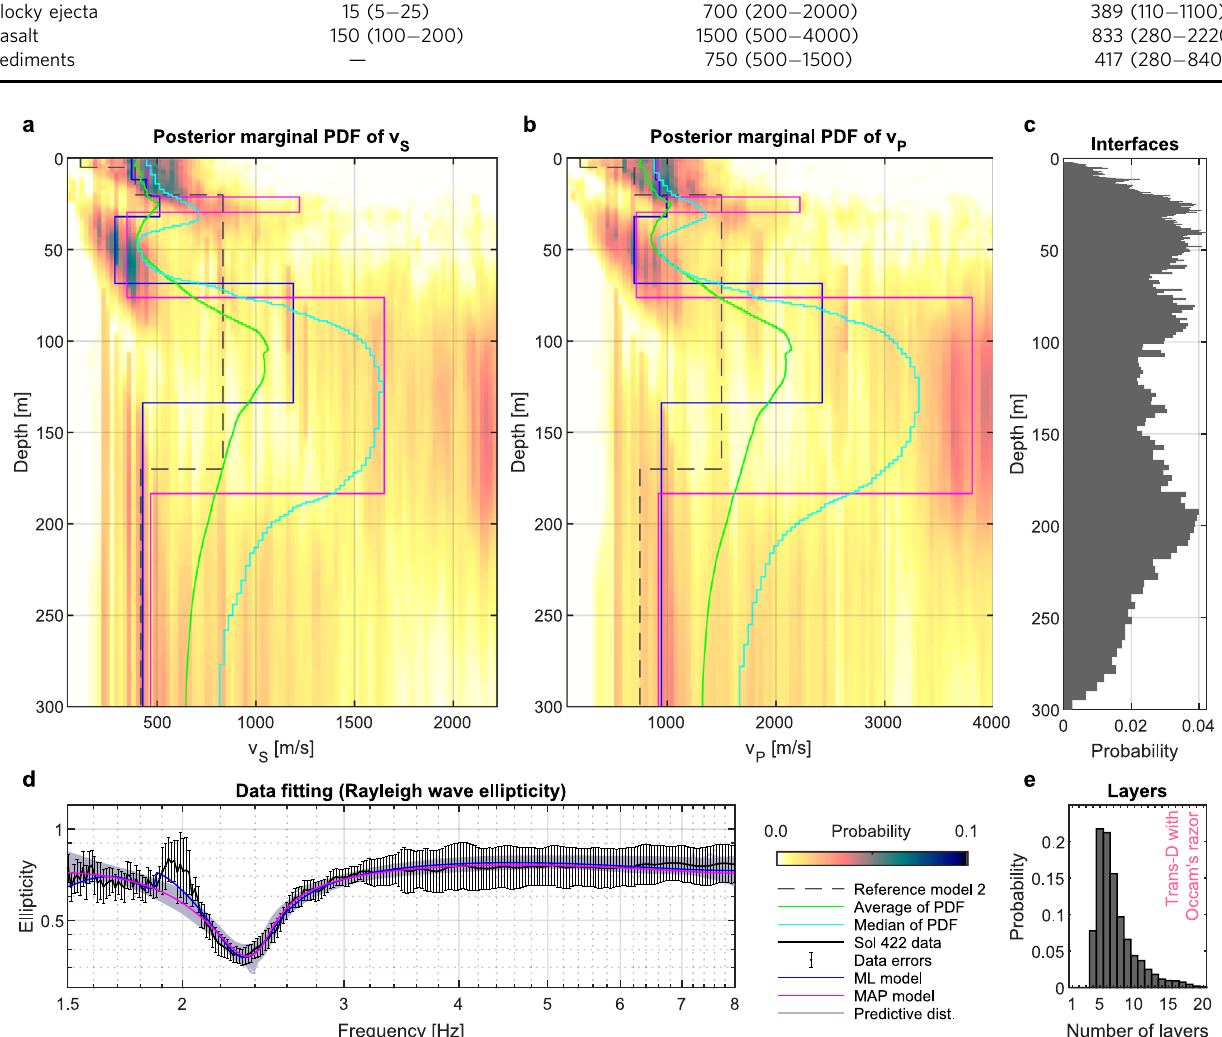
Fig. 5 Result of the inversion of the Rayleigh wave ellipticity curve using a fl at prior probability density function (PDF). a , b show the posterior marginal probability density functions of v S and v P , respectively. c Histogram of the occurrence of layer interfaces. d Extracted (black line) and modeled ellipticity curves for models drawn from the posterior PDF (ML maximum likelihood, MAP maximum a posteriori). Vertical bars indicate the expected data error (used as inverse data weight). e Posterior histogram of the number of layers.